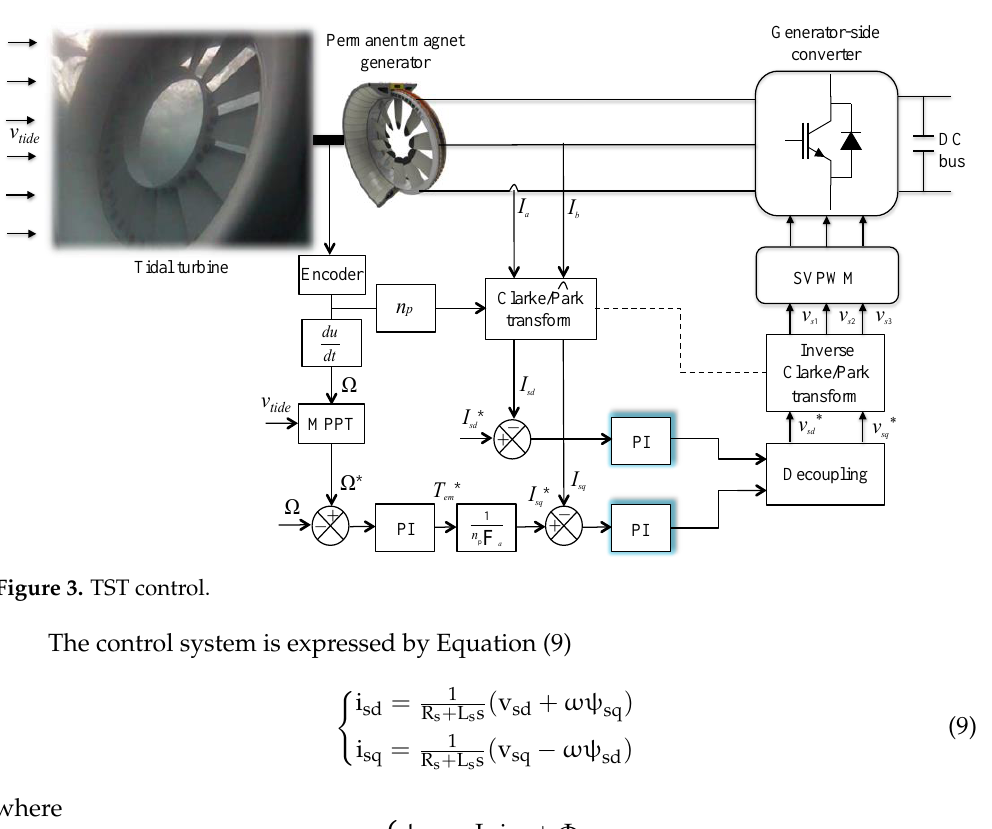
Fig. 7. Full-pow er neutral-point-clam ped back-to-back converter topology.